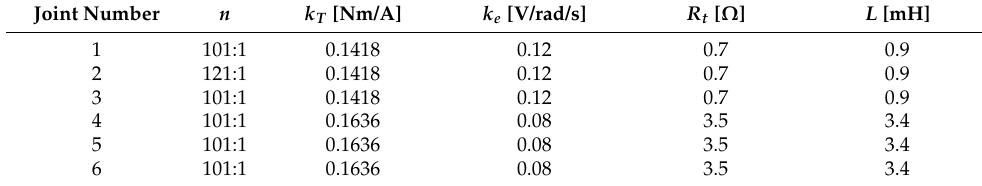
Table 1. Parameters of the ES5 robot drive